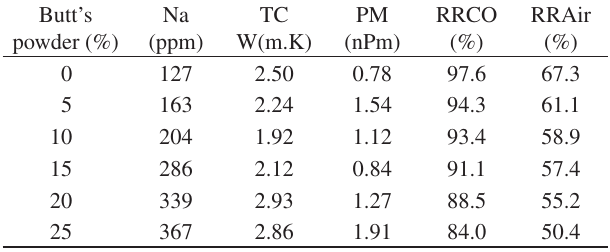
Table 2. Results of the analyses of the samples prepared in bench scale.